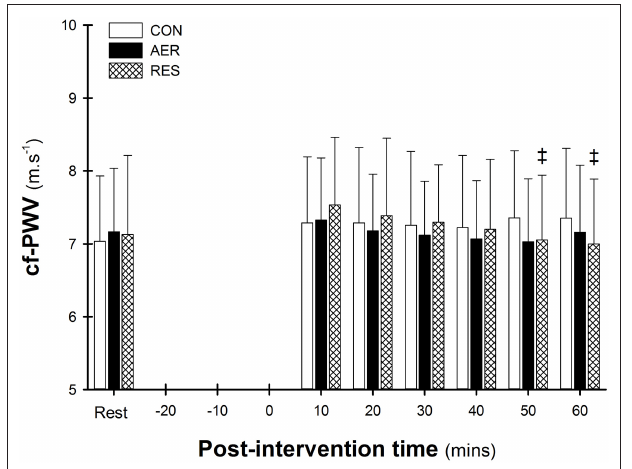
FIGURE 1 | Carotid-to-femoral pulse wave velocity (cf-PWV) at rest and post-intervention. Data are presented as mean ± SD. ‡ p < 0.05 significantly different to 10min (intervention-time interaction).